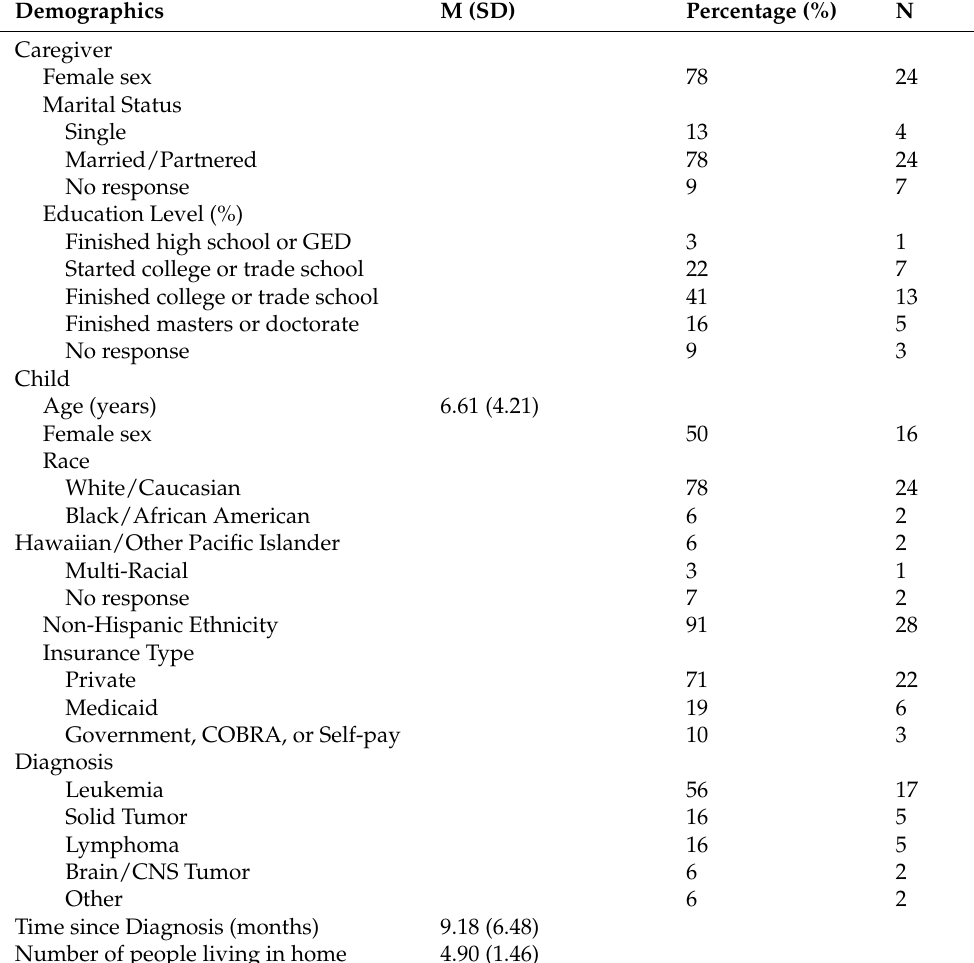
Table 1. Demographic Characteristics of Participating Caregivers (N = 31) and their Children Receiv- ing Cancer